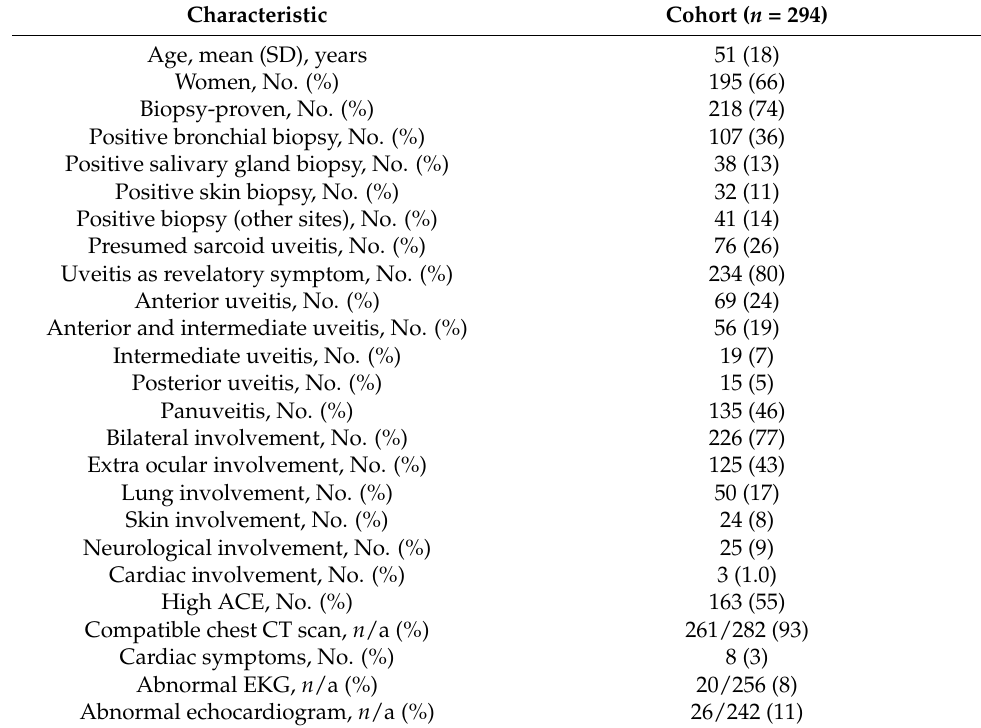
Table 1. Characteristics of 294 patients with sarcoid uveitis at